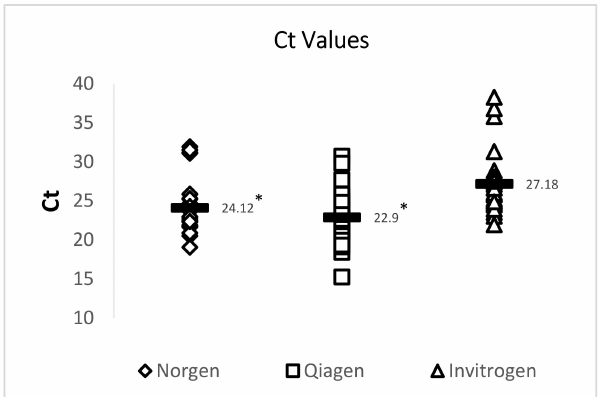
Figure 3. Analysis of the Ct values of TSV amplicons generated by RT-qPCR. Three commercially available extraction kits were utilized for total RNA extraction and total RNA isolated from archived TSV-infected DFPE shrimp tissues was used to generate a 72 bp amplicon of the TSV genome. The horizontal line in each group represents a geometric mean of the Ct values of the corresponding vertical data set. Asterisks represent statistical significance ( p <